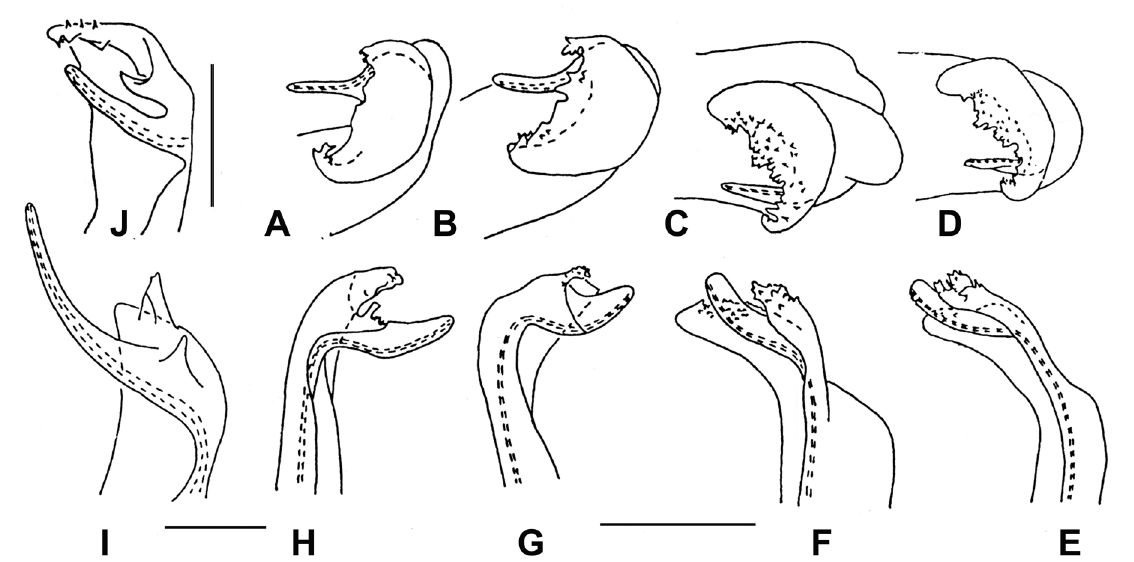
Fig. 3. Levizonus circularis Takakuwa, 1942, ♂♂, from Russia (A–I) and North Korea (J). A–D . Variations in shape of distal part of gonopod telopodite, ventral view. E–J . Variations in shape of distal part of gonopod telopodite, lateral view. Scale bars: A–D, J = 0.25 mm; E–G = 0.2 mm; H–I = 0.1 mm. A–H: after Mikhaljova 1981a; I: after Lokschina & Golovatch 1977; J: after Mikhaljova et al.